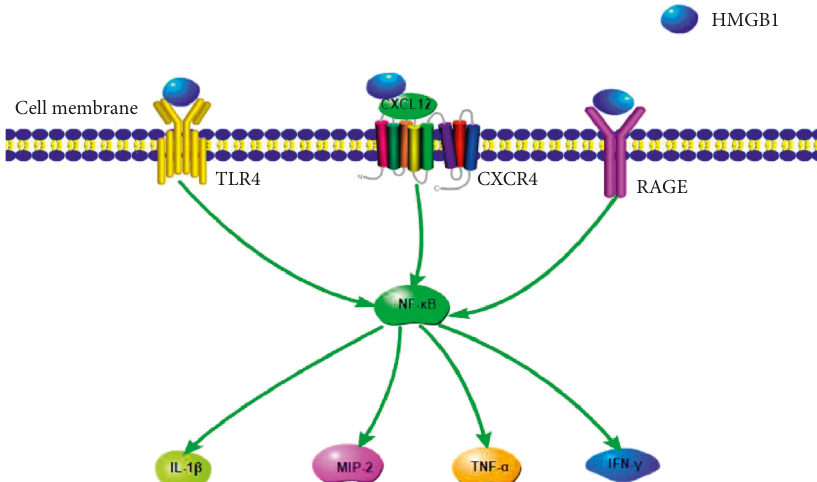
Figure 3: Signaling pathways downstream of RAGE, TLR4, and CXCR4 mediate the effects of HMGB1 in corneal diseases. RAGE signals, TLR4 signals, and CXCR4 signals promote the activation of NF- κ B. After the activation of NF- κ B, the inflammatory cytokines such as IL-1 β , MIP-2, TNF- α , and IFN- c are